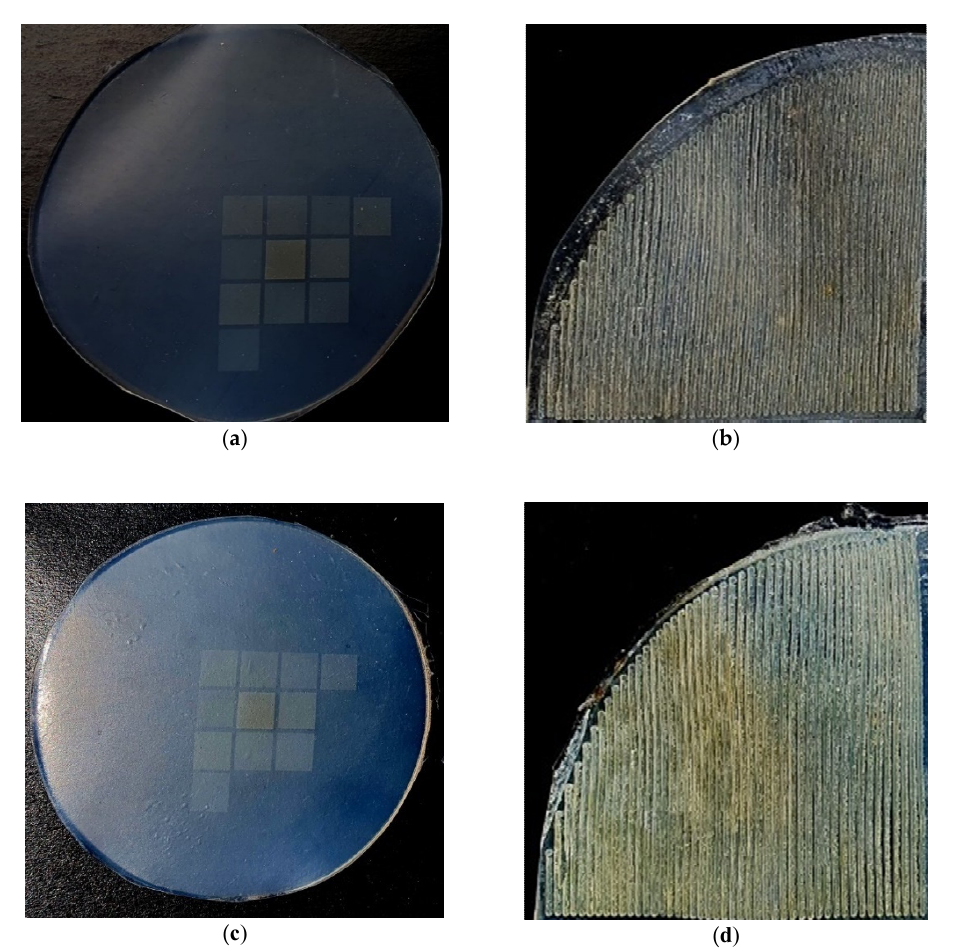
Figure 6. The photos of samples after laser texturing: ( a , b )—MVQ silicone rubber; ( c , d )—MVQ/C1 silicone rubber; ( a , c )—samples with smooth surface; ( b , d )—samples with geometrised surface.